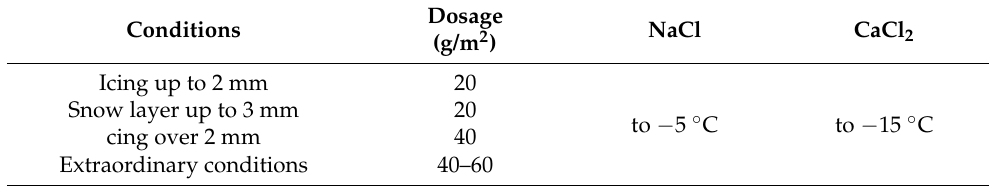
Table 2. Recommended dosage of chemical de-icing materials in the Czech